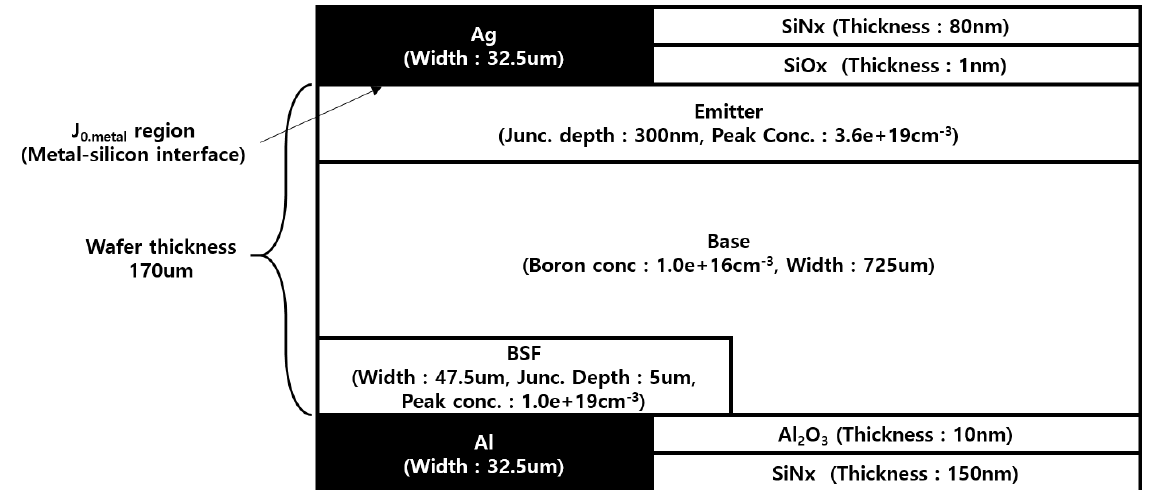
Figure 2. Schematic diagram and definition of periodic boundary domain on simplified PERC solar cell structure to perform a Technology Computer-Aided Design (TCAD) simulation for numerical